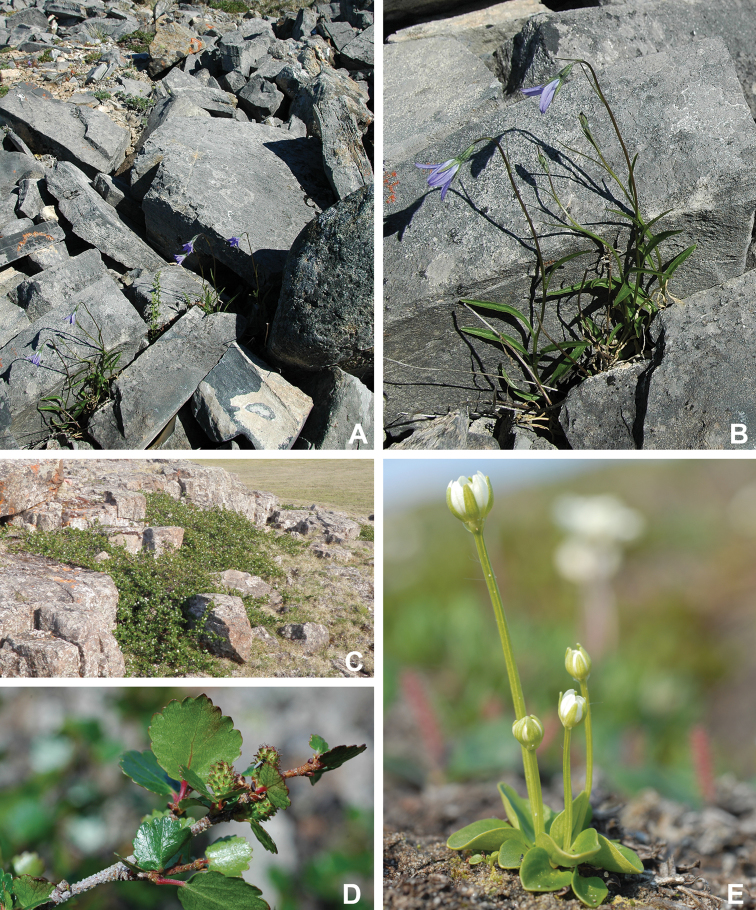
ACampanula
uniflora habitat, Gillespie et al. 9680BCampanula
uniflora habit, Gillespie et al. 9680CBetula
glandulosa habit, Gillespie et al. 9623DBetula
glandulosa inflorescence and leaves, Gillespie et al. 9623. EParnassia
kotzebuei habit, Gillespie et al. 8127. Photos A, B, D, E by R.D. Bull and C by L.J. Gillespie.